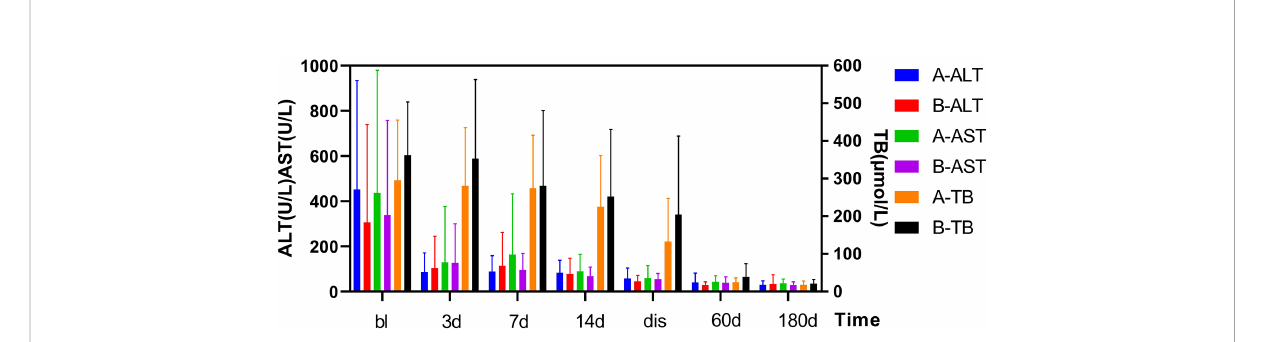
FIGURE 2 Changes in TBil and ALT/AST levels before and after treatment in two Groups. After treatment, the TBil, and ALT/AST levels decreased signi fi cantly. Results are presented as the mean value ± standard deviation. There was not a statistically signi fi cant in the TBil, and ALT/AST levels between the two groups. bl, baseline; dis, discharge; TBil, total bilirubin; AST, aspartate aminotransferase; ALT, alanine aminotransferase.